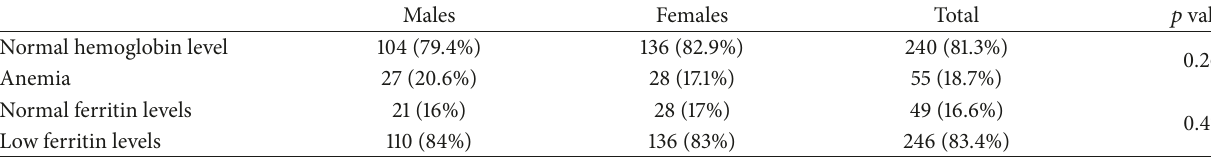
Table 2: Frequency of anemia and low ferritin in males, females, and all subjects.